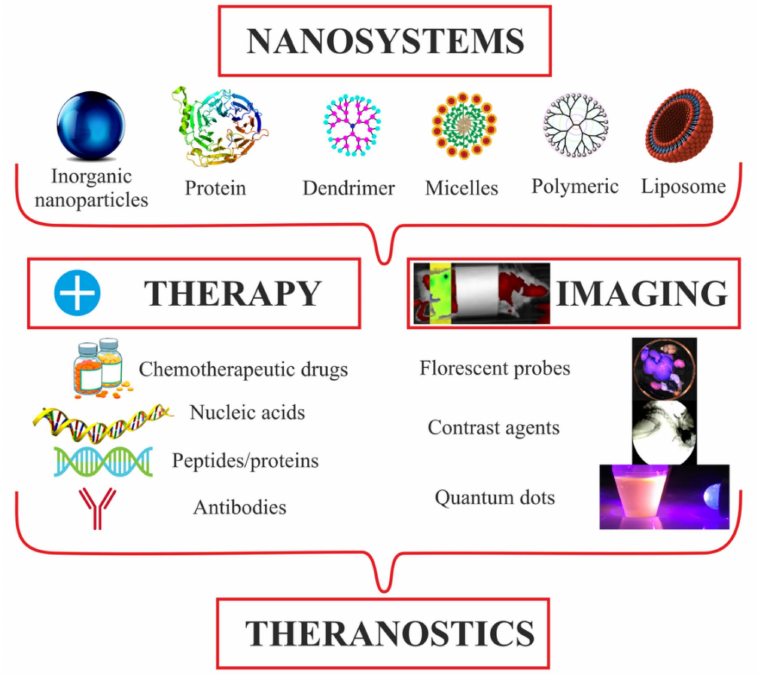
Figure 15. Generalized scheme of theranostics in